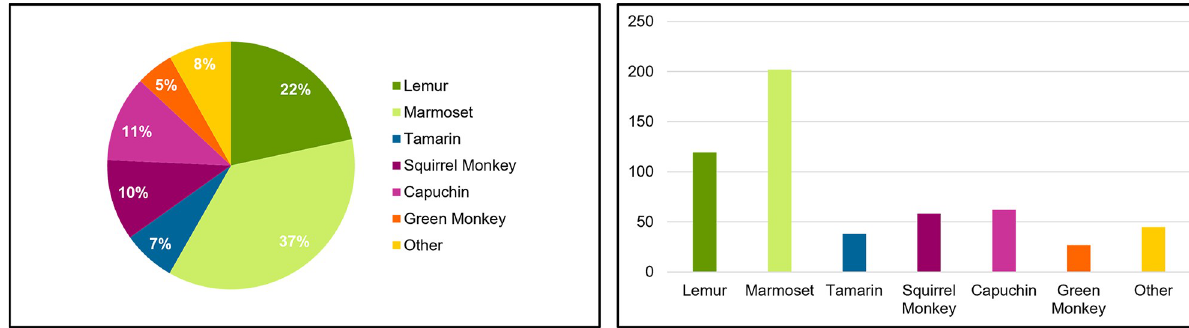
Fig 1. a and b. Primates for sale in the United States. Proportion of pet primates for sale. Number of Primates for sale.